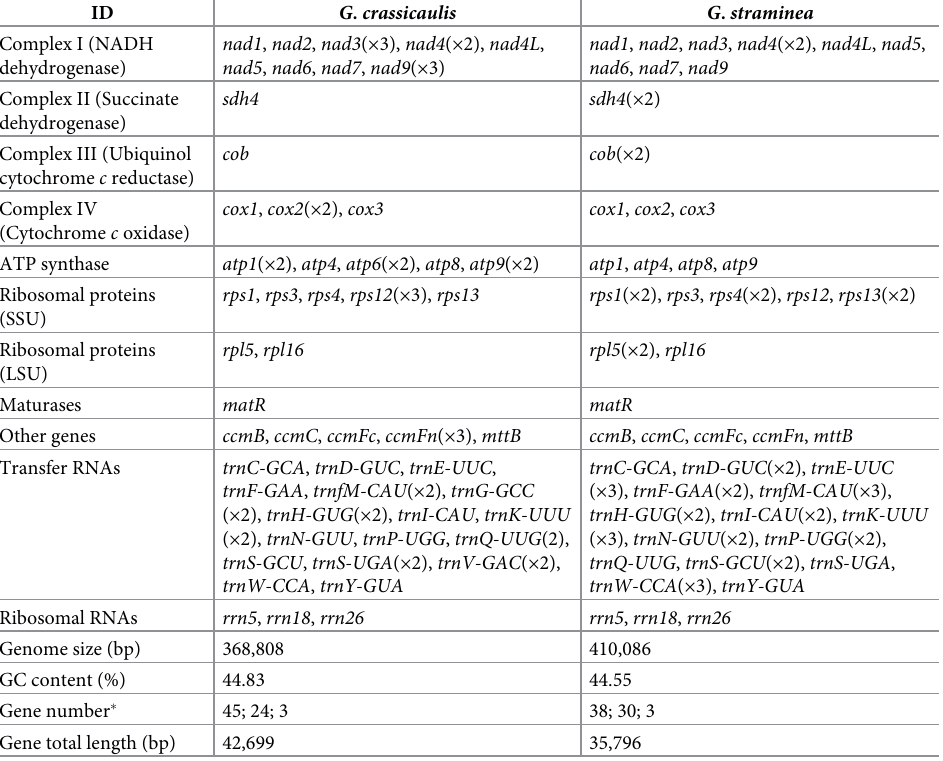
Table 1. Gene component of the mitochondrial genomes of Gentiana crassicaulis and G . straminea . ID G . crassicaulis G .